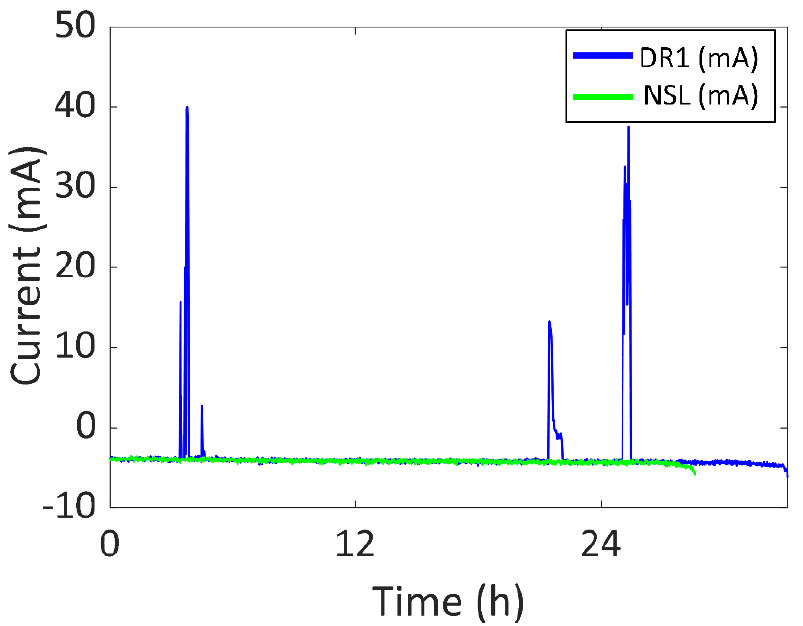
Figure 13. Battery current vs. time of DR1 and NSL